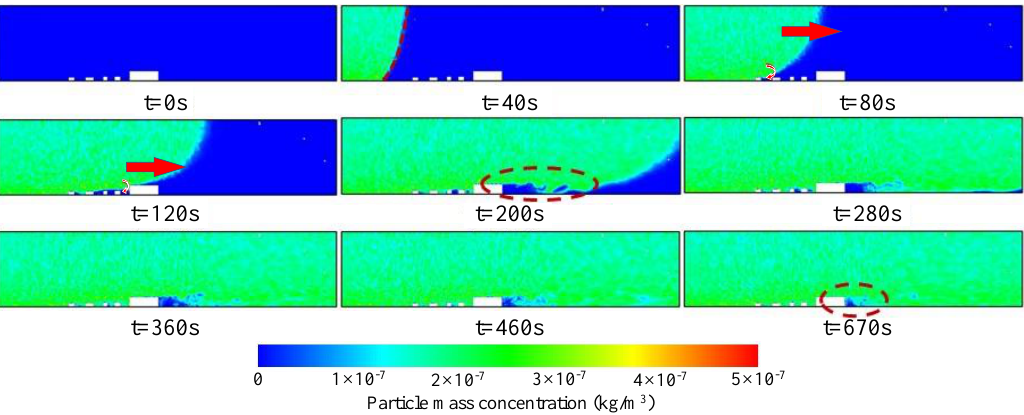
Figure 8. Contours of particle mass concentration on the plane of y = 0 m at the dispersion phases from t = 0 s to t = 670